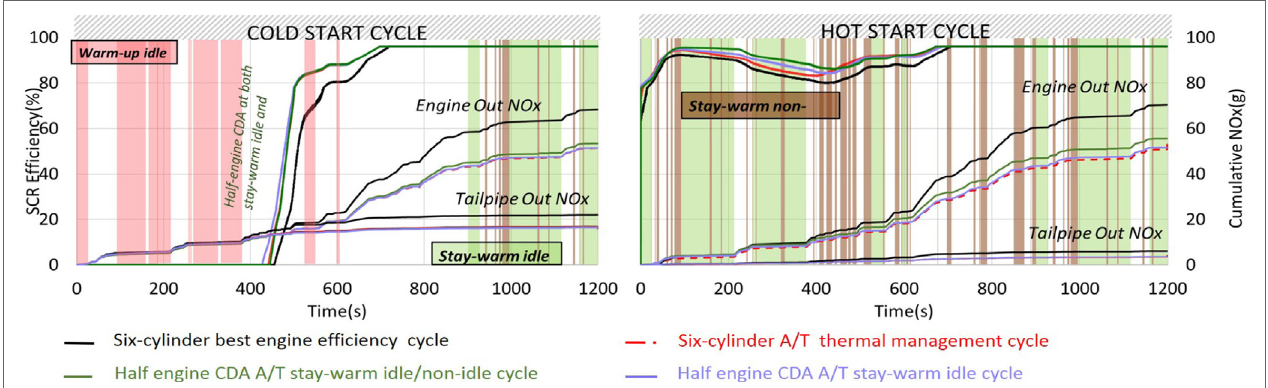
FigUre 17 | The improved SCR outlet temperatures for the “Six-cylinder A/T thermal management cycle,” “Half-engine CDA A/T stay-warm idle cycle,” and “Half-engine CDA stay-warm idle/non-idle cycle” result in greater SCR efficiencies relative to the “Six-cylinder best engine efficiency cycle.” The early fuel injections used during the “Six-cylinder best engine efficiency cycle” lead to increased engine-outlet NOx rates for that cycle. The aforementioned SCR efficiency and engine-out NOx responses result in cumulative tailpipe-out NOx levels for the “Six-cylinder A/T thermal management cycle” and “Half-engine CDA A/T stay-warm idle cycle” that are similar and notably lower than those for the “6 cylinder best engine efficiency cycle.” Relative to the other cycles, “Half-engine CDA A/T stay warm idle/non-idle cycle” has higher SCR efficiencies which result in a reduction in tail pipe out NOx.